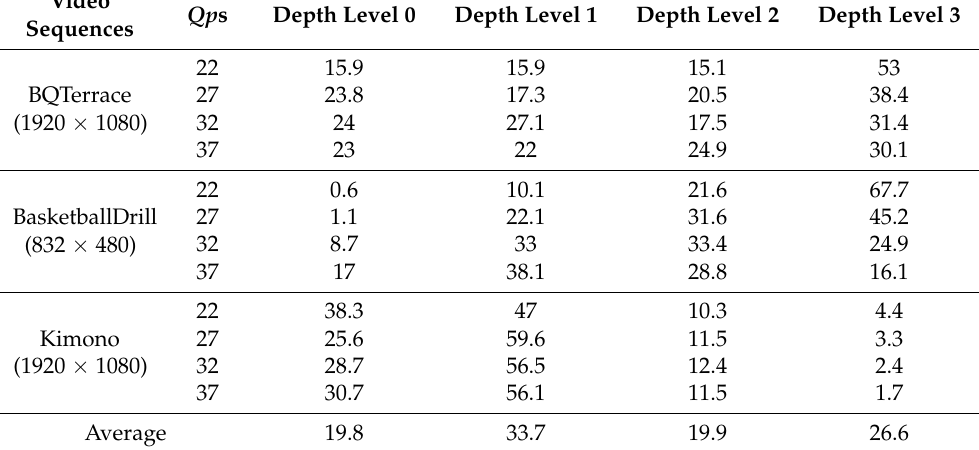
Table 1. Depth level distribution